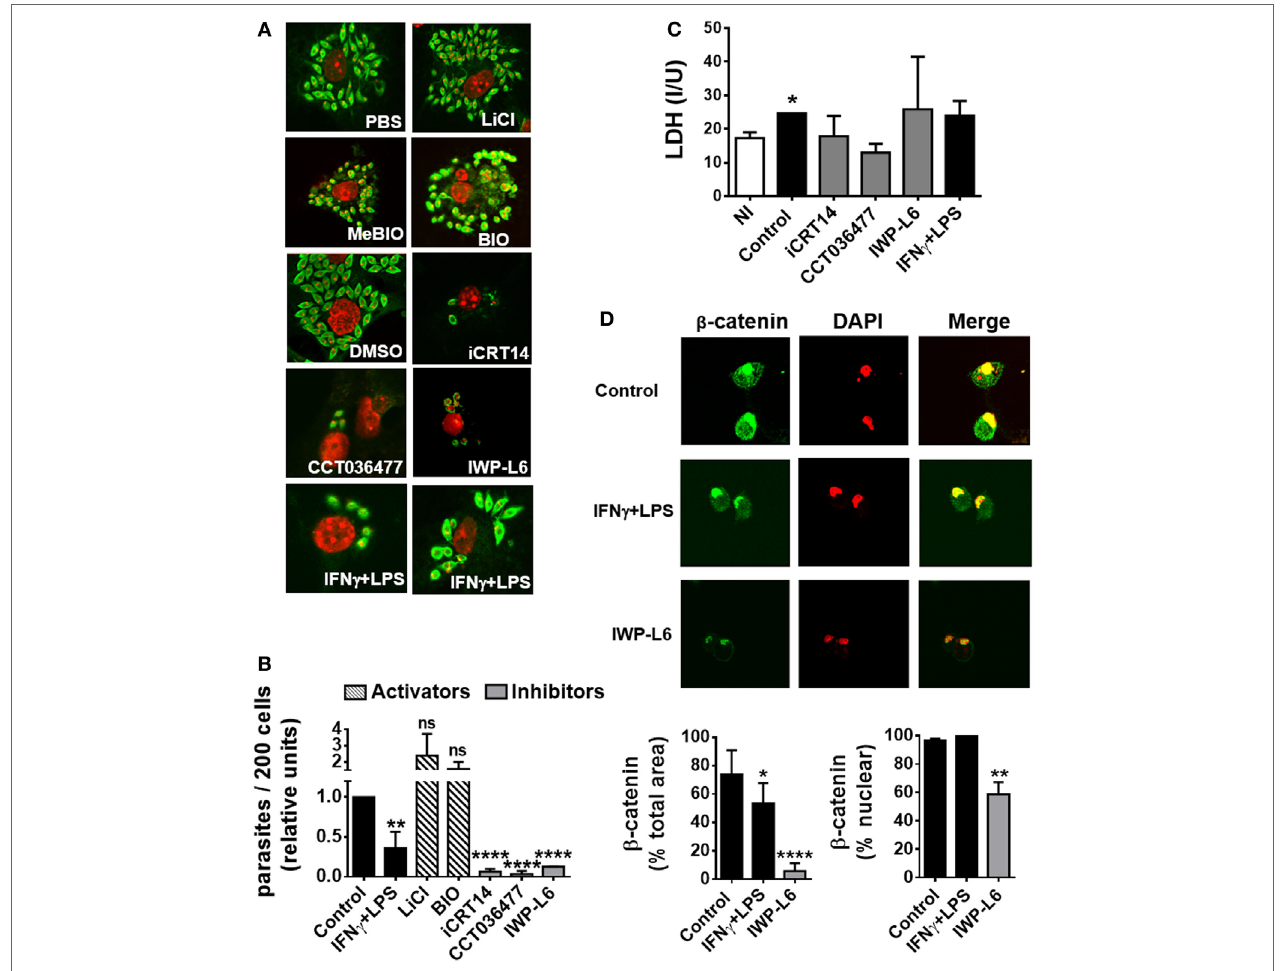
FigUre 5 | The activation of Wnt signaling pathway promotes the replication of Trypanosoma cruzi in macrophages. Bone marrow-derived macrophages (BMM) were treated for 24 h with β -catenin activators (LiCl or BIO), specific β -catenin transcriptional inhibitors (iCRT14 and CCT036477), PORCN inhibitor (IWP-L6), or IFN γ plus LPS as BMM activation control. Then, the cells were infected with trypomastigotes of T. cruzi , and intracellular parasites were counted by immunofluorescence assay. (a) A representative field for each group is shown (2,000 × ). PBS or DMSO was used as vehicle for LiCl or iCRT14, CCT036477, and IWP-L6, respectively. MeBIO was used as control of BIO treatment. (B) The number of intracellular amastigotes was determined by confocal microscopy. Bars represent relative units, calculated by dividing number of intracellular parasites ( n /200 cells) in differentially treated cultures by number of intracellular parasites ( n /200 cells) in the corresponding vehicle-treated cultures. (c) Lactate dehydrogenase (LDH) levels were determined in the culture supernatant of uninfected (NI) or differentially treated infected BMM at 24 h post-infection. (D) Effect of IWP-L6 treatment on β -catenin activation. Accumulation and nuclear translocation of β -catenin in untreated (control), IFN γ plus LPS- or IWP-L6-treated T. cruzi- infected BMM was calculated as described in Section “Materials and Methods.” A representative field for each group is shown (1,200 × ). Bars in panels (B–D) represent averages ± SEM from three (c) or four (B,D) independent experiments (* P < 0.05; ** P < 0.01; *** P < 0.001; and **** P <